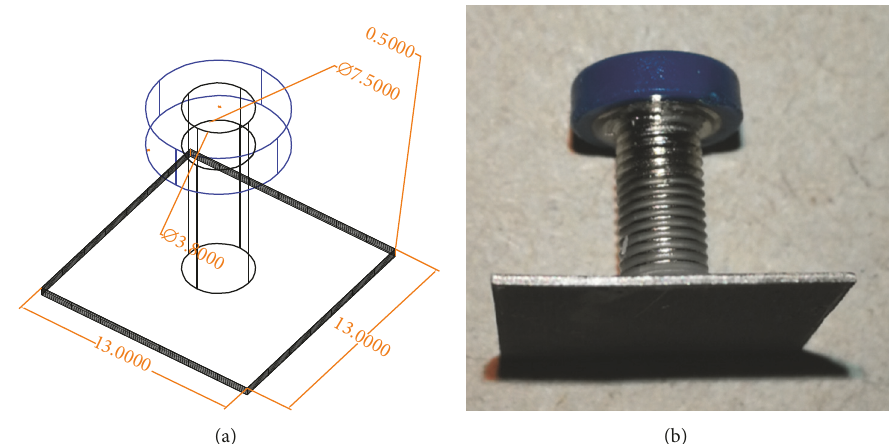
Figure 4: Electrode design layout using AutoCAD (a). The real electrode (b); square contact areas are 13 × 13 × 0.5 mm 3